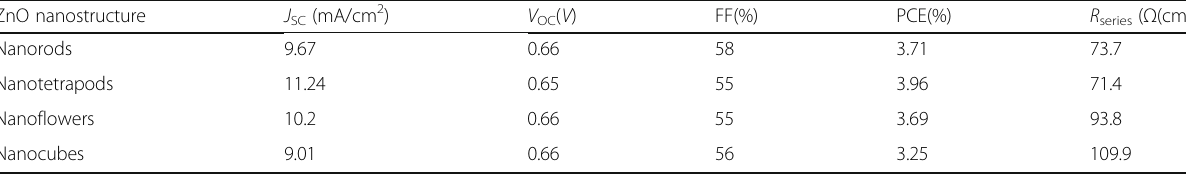
Table 1 The device performance of the organic bulk heterojunction solar cells ZnO nanostructure